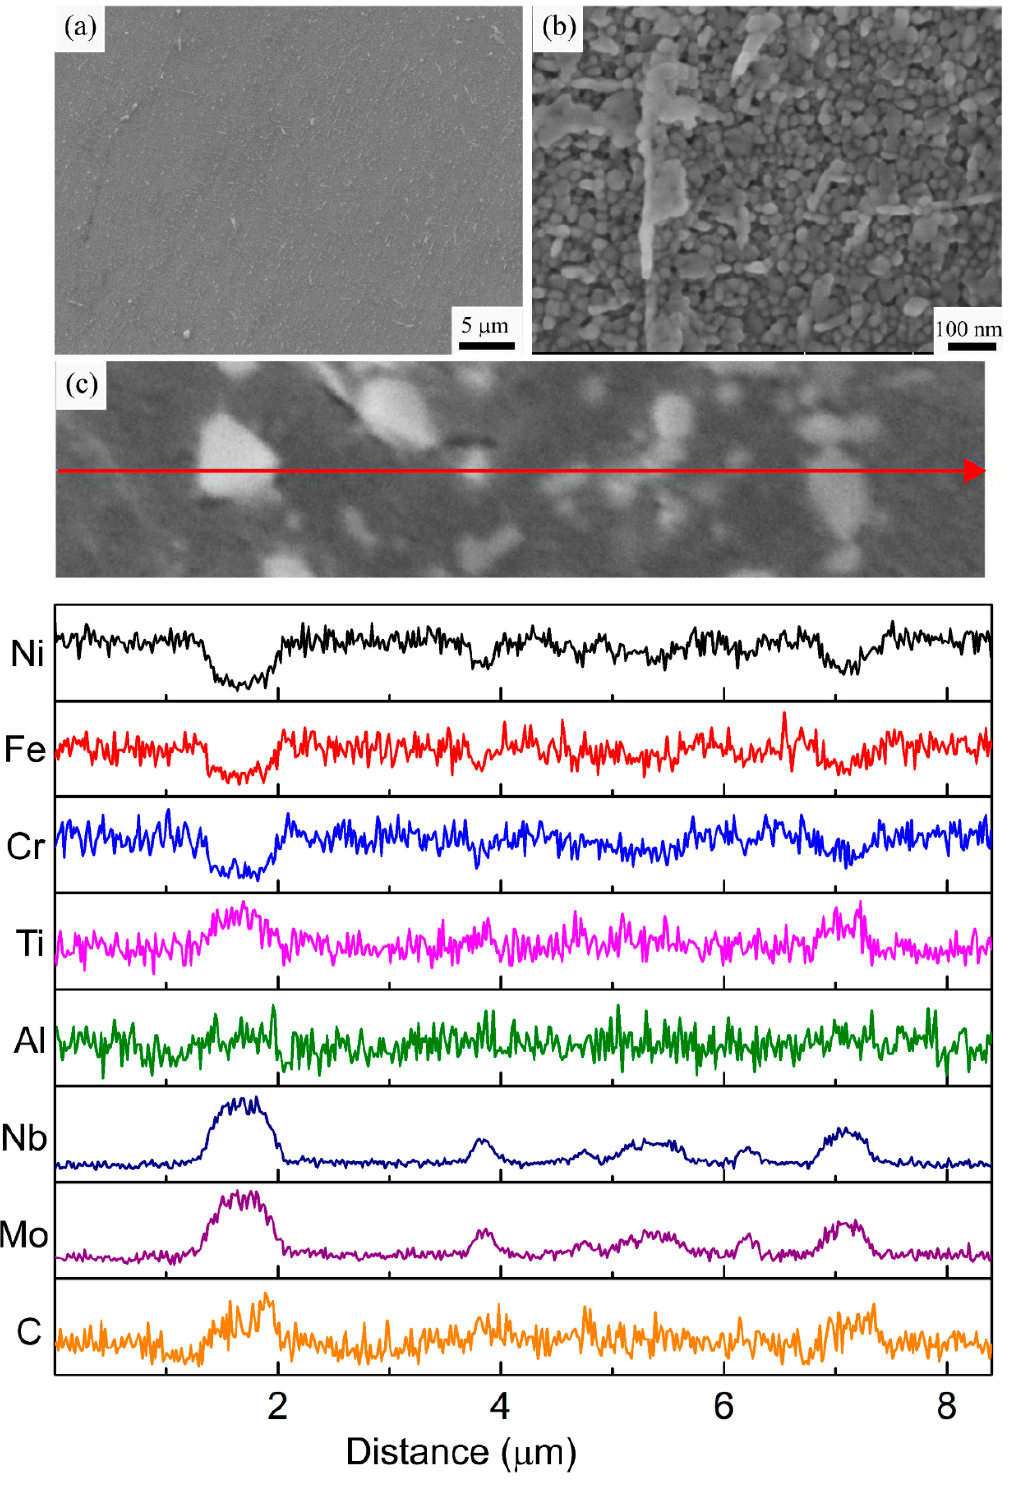
Figure 10. ( a , b ) Representative SEM micrographs, ( c ) EDS line scan analysis of the HT3 specimen along the marked red arrow.